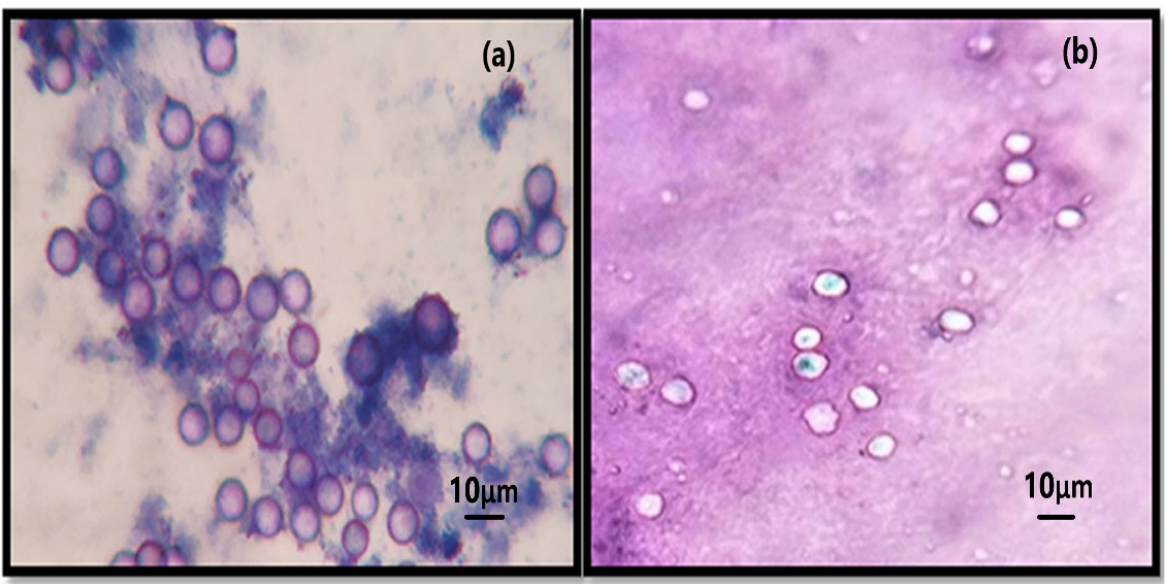
Figure 4. Cysticidal activity of SeNPs–Cipro conjugates: ( a ) Cyst treated with SeNPs–Cipro conjugate; ( b ) control cyst excludes trypan blue.